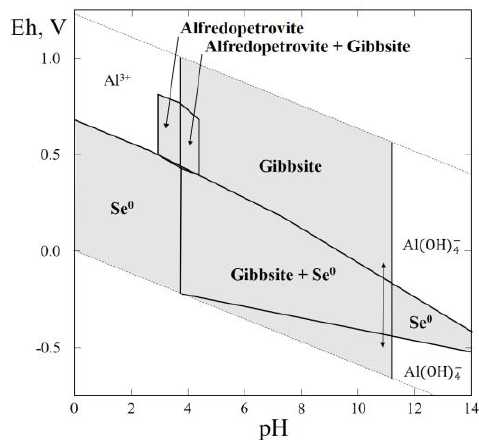
Figure 14. Eh-pH diagram of the OHSeAl (Al-Se-H 2 O) system at 25 °C and the activities of the components: a ΣSe = 10 − 4 , a ΣAl = 10 − 3 .